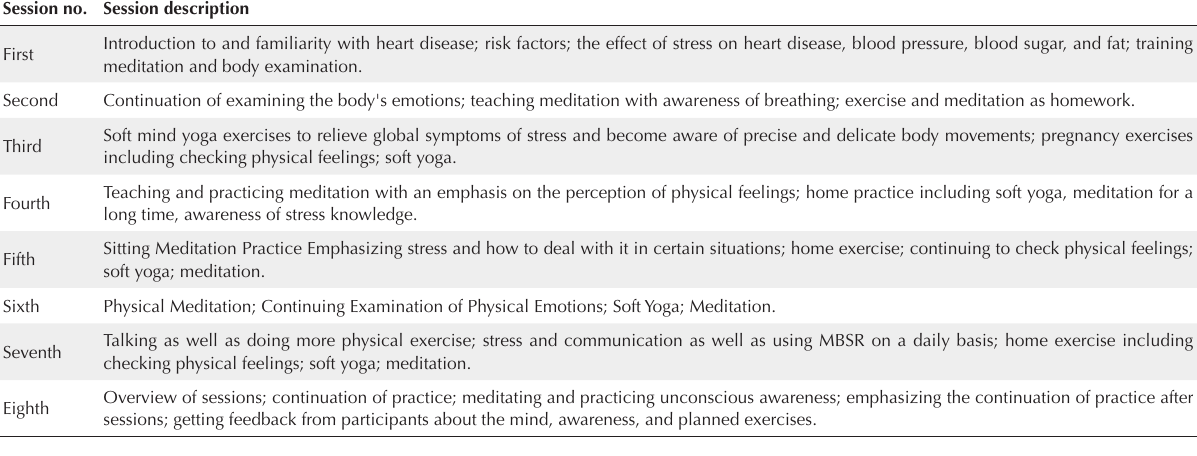
Table 1. Summary of sessions of mindfulness-based stress reduction therapy with a cognitive approach Session no. Session description